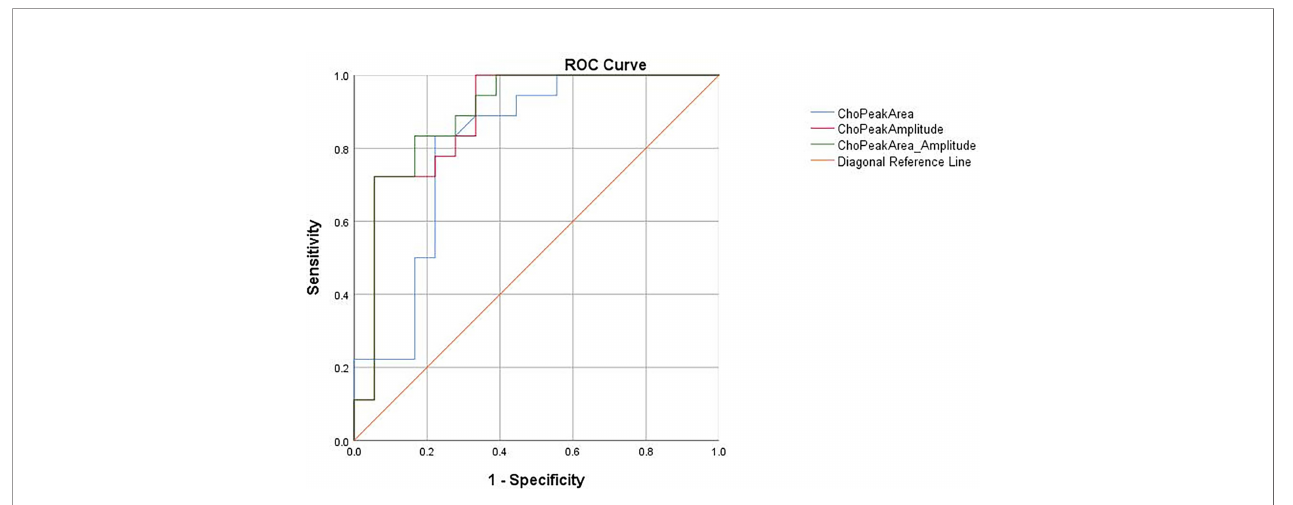
FIGURE 4 | The receiver operating characteristic (ROC) curves for the diagnosis of liver cancer based on choline peak area (Cho Are), choline peak amplitude (Cho Amp), and choline peak area combined with choline peak amplitude (Cho